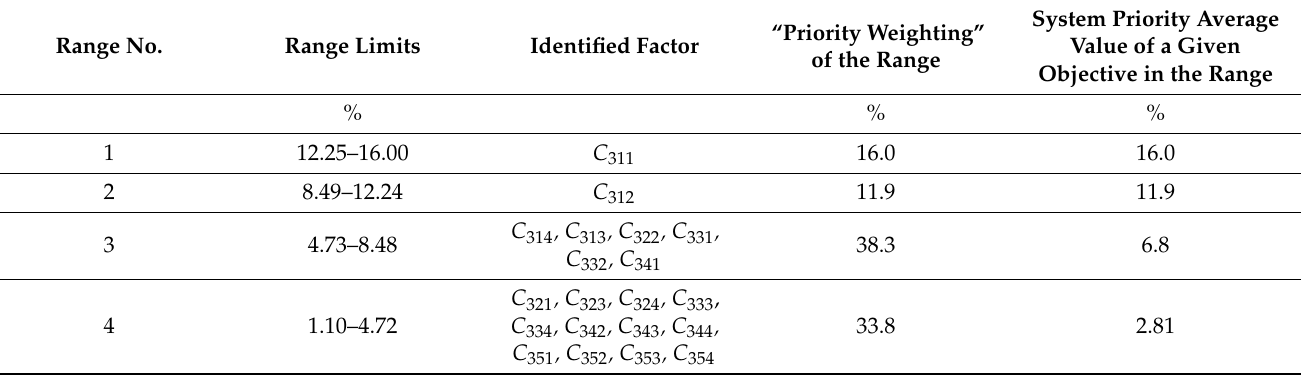
Table 3. Significance rank of level III factors.